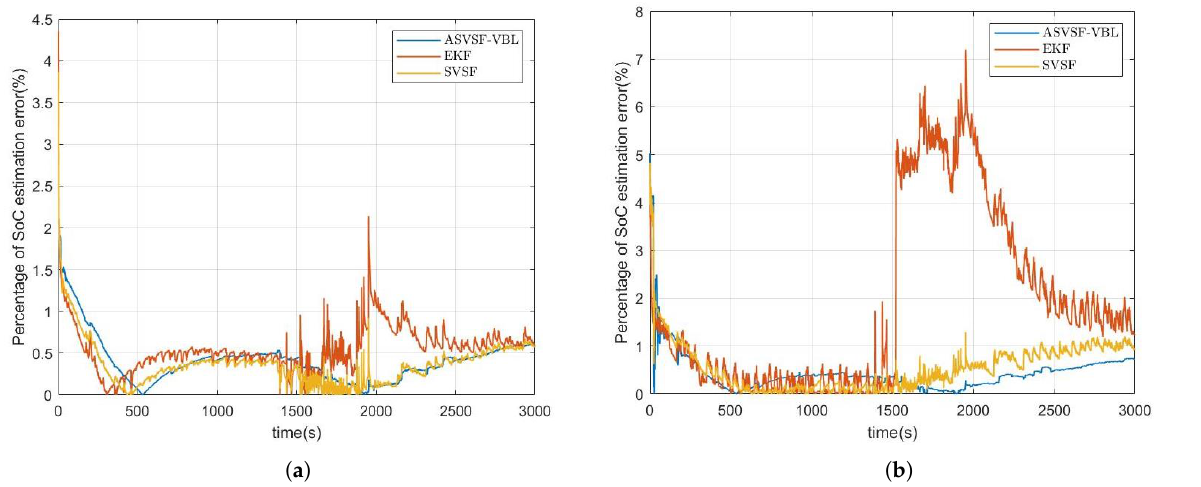
Figure 9. ( a ) Percentage of estimated SoC error for an ideal scenario, ( b ) Percentage of estimated SoC error in presence of noise and current bias.